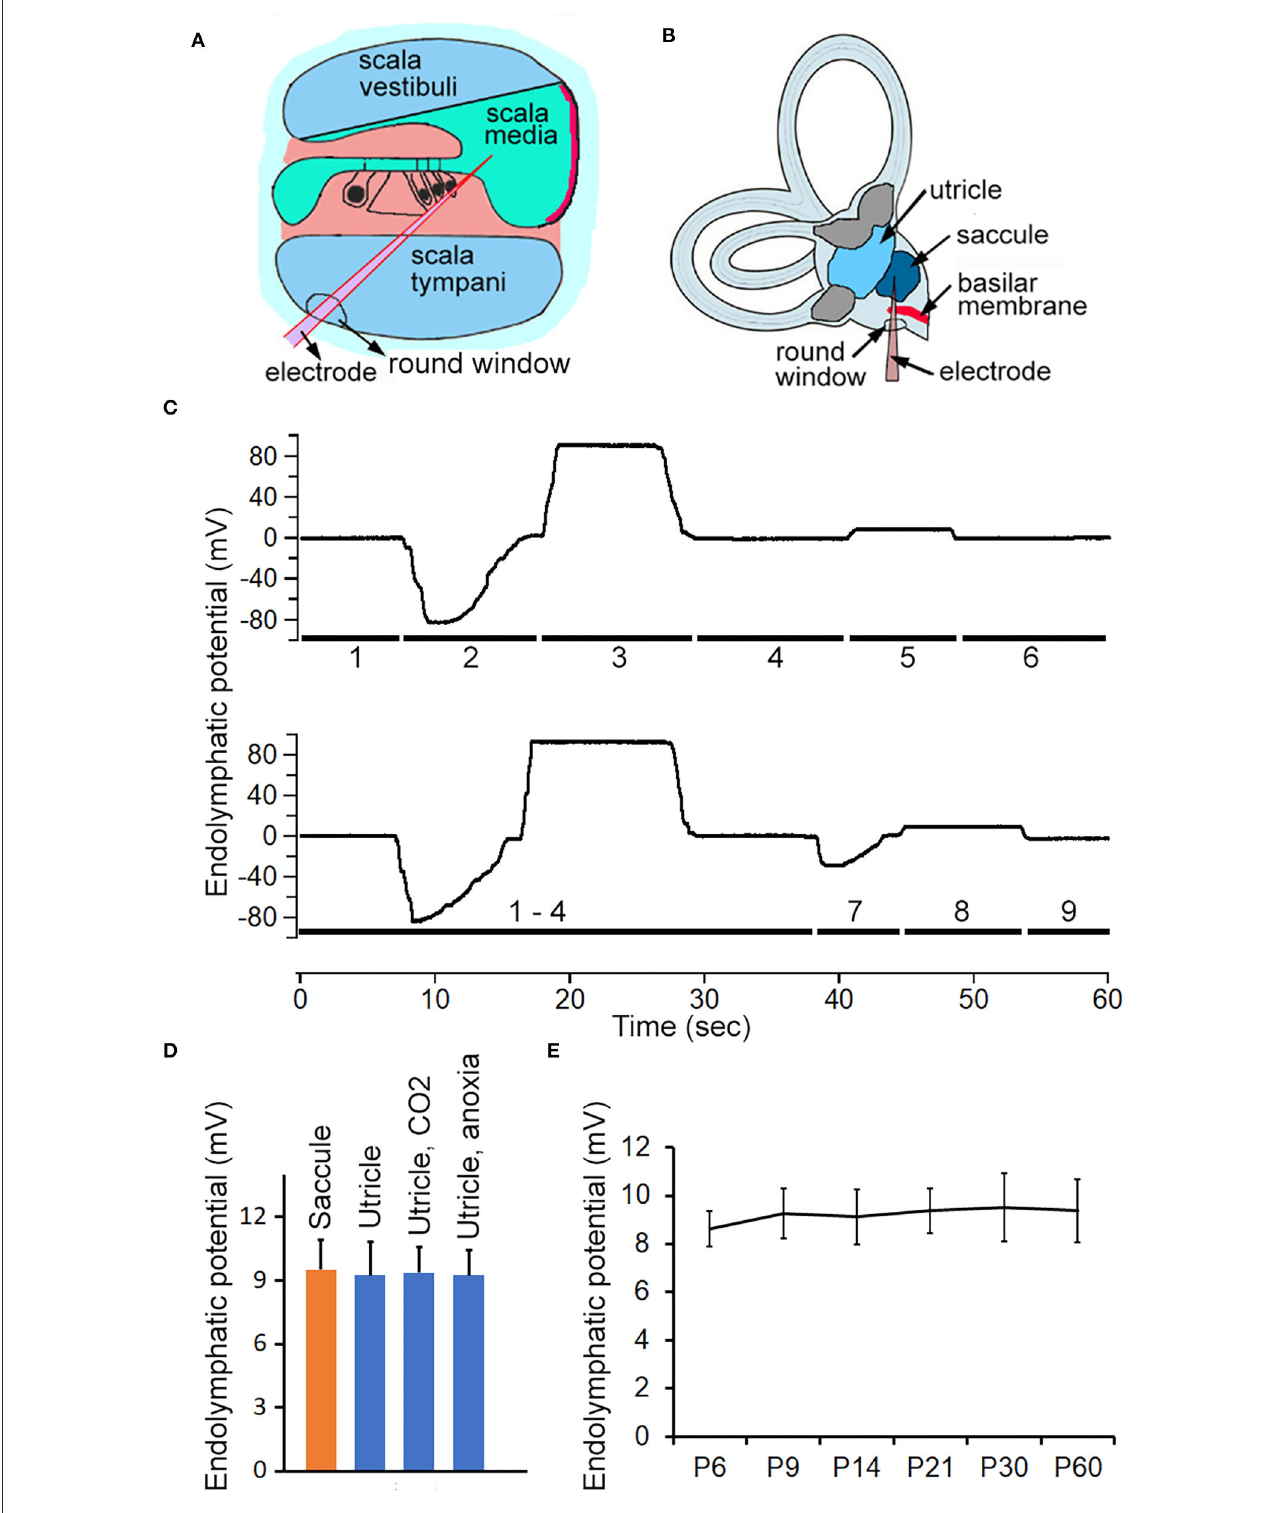
FIGURE 3 | Recording ELP from cochlea, saccule and utricle in adult and neonatal mice. (A) Schematic view of electrode path for recording EP through round window approach. (B) Electrode path for recording ELP from saccule through round window. (C) Representative examples of changes in recorded potential